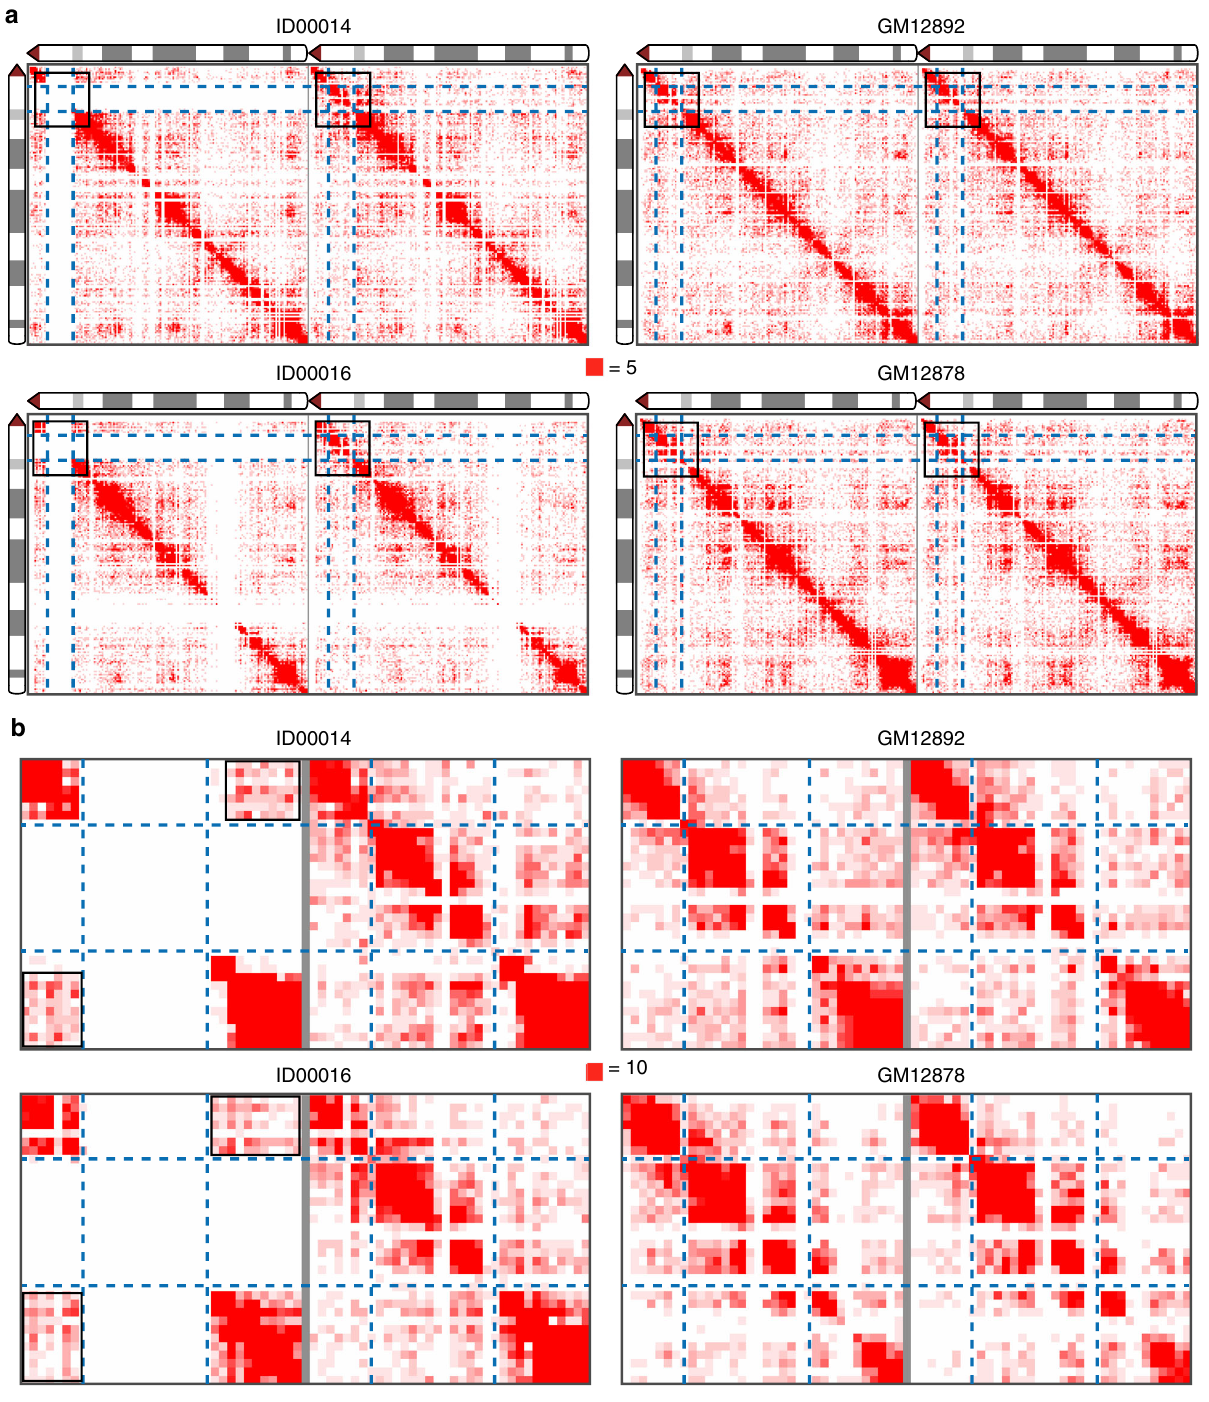
Fig. 2 Haplotype-speci fi c intra-chromosomal contacts of chromosome 22q. a Contacts within each homologous chromosome 22q for patients (ID00014 and ID00016) and controls (GM12878 and GM12892) at 200 kbp resolution. The chromosome 22q with 22q11.2 deletion is shown on the left for the two patient cell lines. Intensity of contacts is represented by a scale from 0 (white) to 5 (deep red). The gap in signal for the region from 39 to 42 Mbp in ID00016 is caused by a very low density of heterozygous SNVs. b Zoomed-in view of the regions in black boxes in a . The color scale goes from 0 (white) to 10 of the homologous chromosome with the 22q11.2 deletion were Hi-C and genome haplotype phasing data are available (Fig. 3d). not affected by the deletion. We did not observe differences in the A/B compartments between cell lines from patients and from controls and neither between the Topological domains (also known as topologically associating two homologous chromosomes 22q in any individual cell line, domains (TADs)) are a megabase-sized structural feature of the patient, or control. Our results indicated that A/B compartments genome organization that is constituted of highly self-interacting